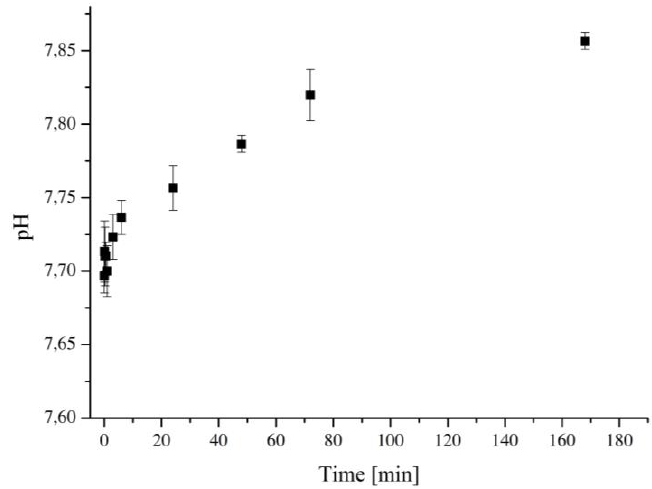
Figure 4. Graph of pH variation with time of the SBF solution after the immersion of Ca_MCM-41 particles.